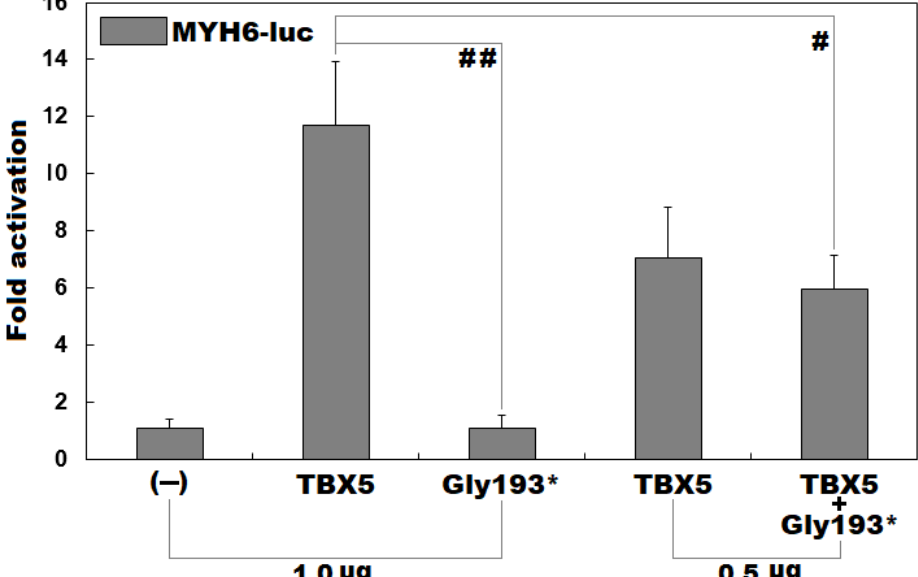
Figure 2 – Functional failure of TBX5 caused by the mutation. Activation of α-myosin heavy chain 6 promoter-driven luciferase in cultured COS-7 cells by wild-type or Gly193*-mutant TBX5, singly or together, revealed that the Gly193*-mutant TBX5 protein had no transcriptional activity. Transfection experiments for each plasmid were carried out in triplicates and the results are expressed as means with standard deviations. Here ## and # indicate p <0.01 and p <0.02, respectively, in comparison with wild-type TBX5.